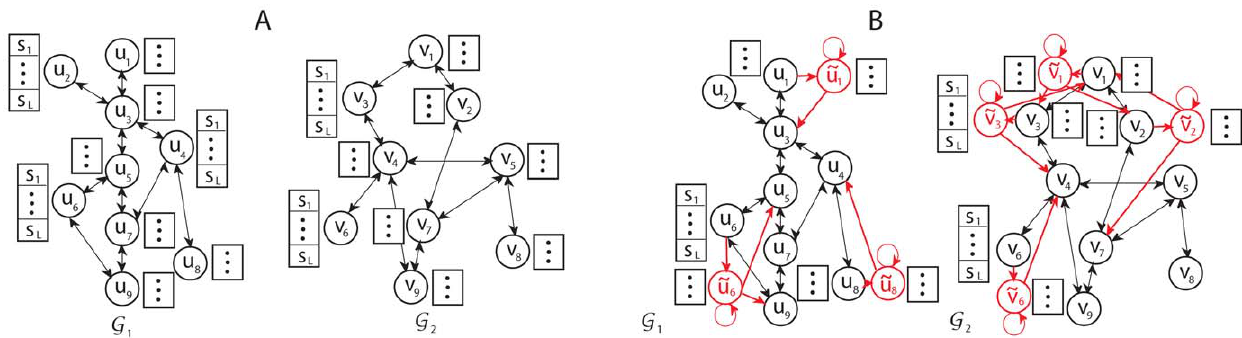
Figure 2. Hidden Markov models for network alignment. (A) Ungapped hidden Markov models (HMMs) for finding the best matching pair of paths. The dots next to the hidden states represent all possible symbols corresponding to virtual nodes in s that can be emitted. (B) Modified HMMs that allow insertions and deletions. For simplicity, changes to the HMMs are shown only for the nodes u 1 , u 6 , and u 8 in G 1 ; v 1 , v 2 , v 3 , and v 6 in G 2 .